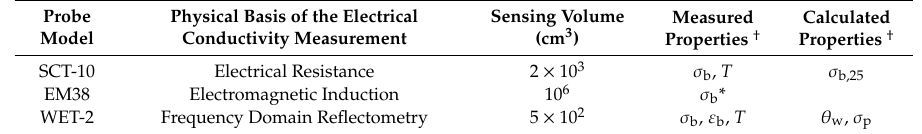
Table 1. Characteristics of the three probes used in this work to measure the soil electrical